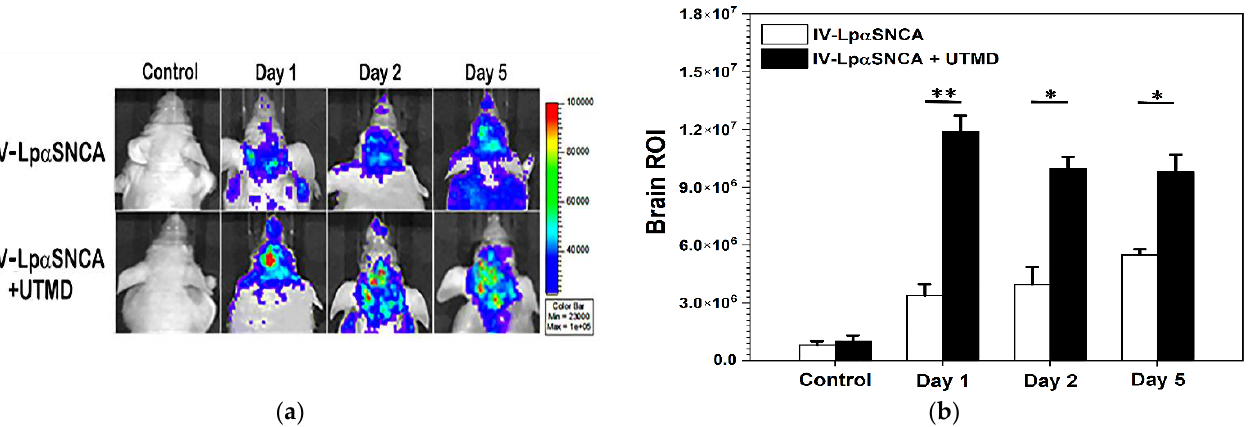
Figure 3. ( a ) Representative peak bioluminescent imaging acquired on day 1, day 2, and day 5 after Lp α SNCA IV infusion +/ − US exposure in the presence of microbubbles (IV-Lp α SNCA vs. IV-Lp α SNCA + UTMD). Transfection efficiency was commenced 1 day after gene transfection; ( b ) Data represent an average photo flux from all injection sites in the group (p/s/cm 2 /sr) ± SD. * p < 0.05; ** p < 0.01 (Mann–Whitney U test); n = 3 for each group. IV = intravenous; UTMD = focused ultrasound-targeted microbubble destruction; Lp α SNCA = liposomal plasmid α -synuclein; ROI = region of